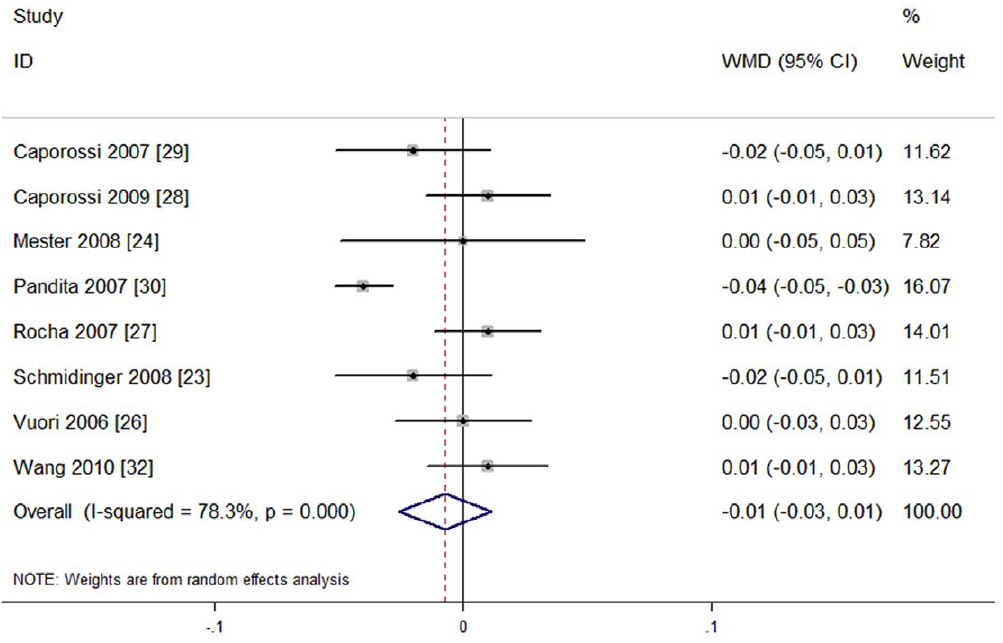
Figure 2. Meta-analysis of postoperative best corrected visual acuity (BCVA).